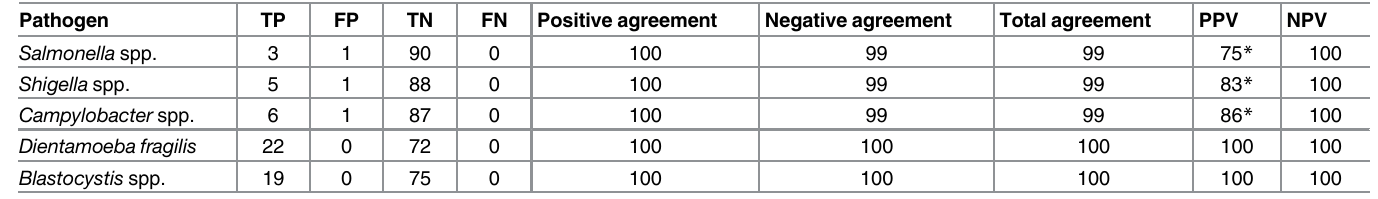
An additional benefit of this evaluation was the detection of the co-infections as detected by the NanoCHIP 1 : Table 6 represents the cases of mixed infections versus the pathogens charac- terized by the conventional methods. Since those samples were not fully elaborated by the Table 5. Discrepant analysis results following the discrepancies shown in Table 4. TP, True Positives; FP, False Positives; TN, True Negatives; FN, False Negatives; PPV, Positive Predictive Value; NPV, Negative Predictive Value. Pathogen TP FP Salmonella spp. Campylobacter spp. Blastocystis